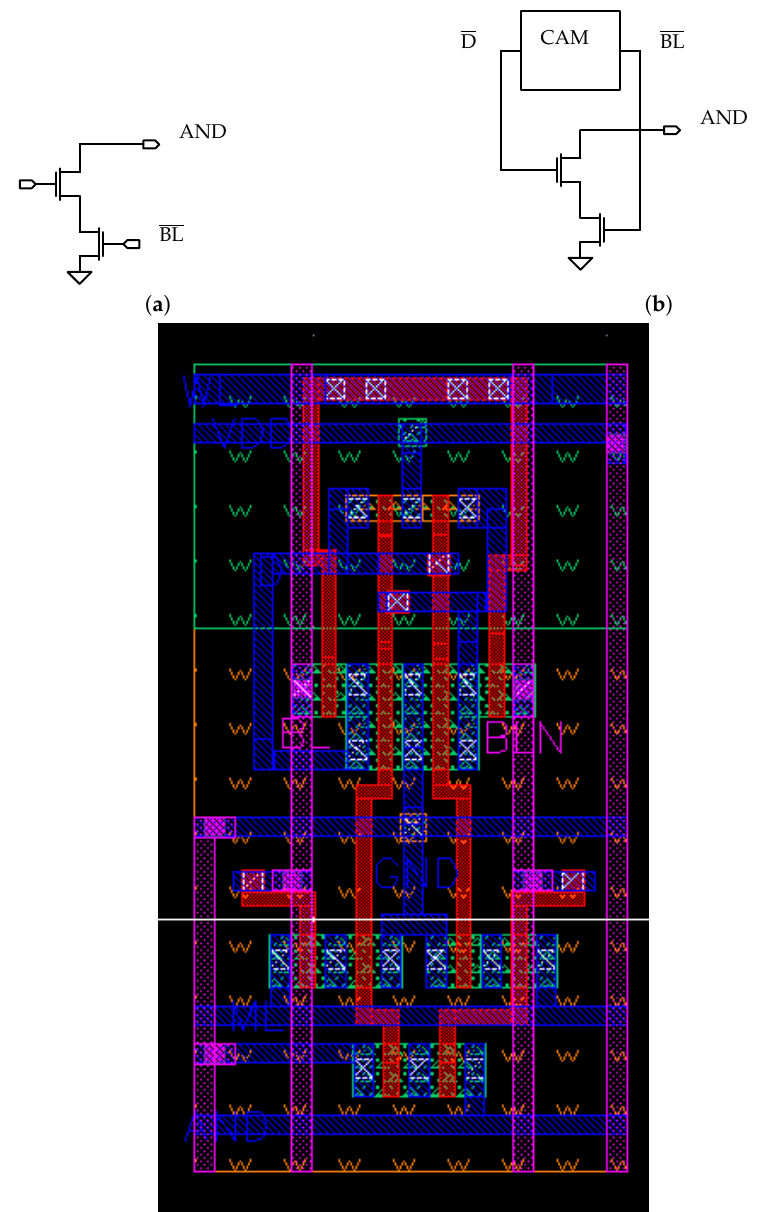
Figure 11. The special-purpose AND gate and memory cell. Taking into account the algorithm characteristics, it is possible to implement the AND operation by using only two additional